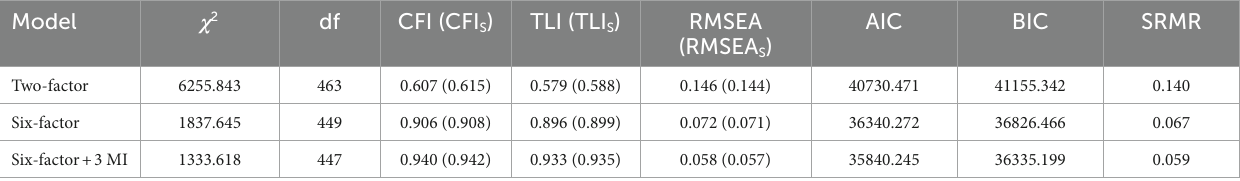
TABLE 3 Goodness-of-fit test for analyzed models.